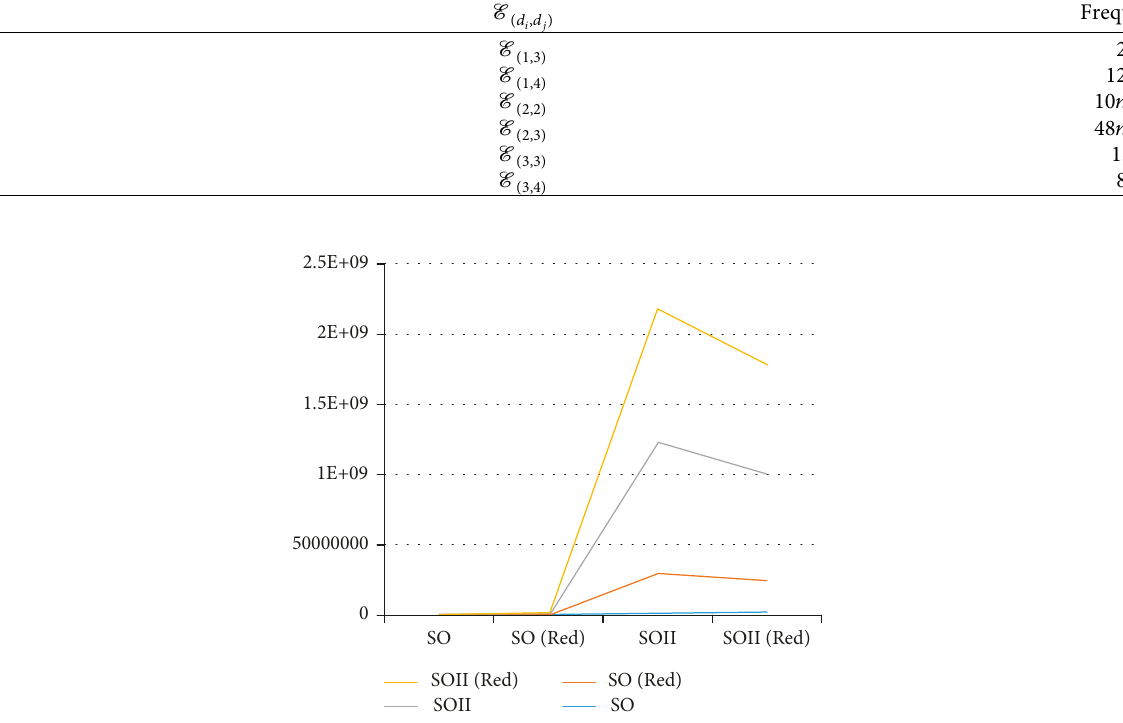
Figure 7: Graphical comparison of SO , SO